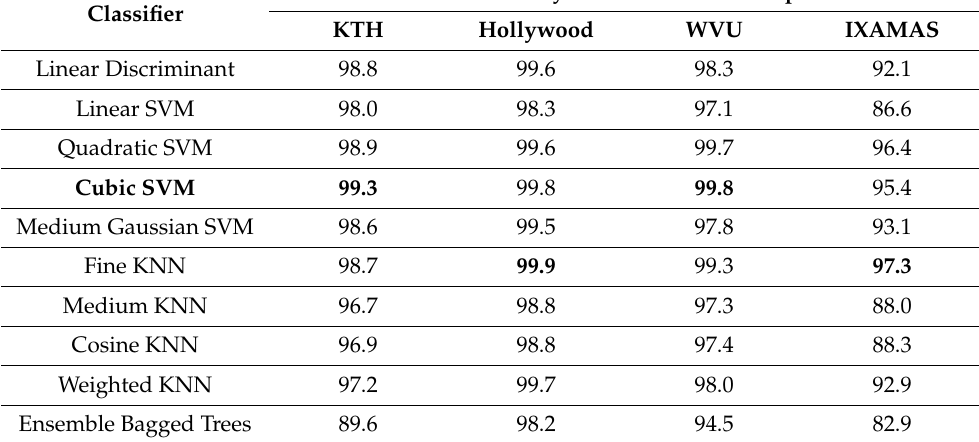
Table 1. Classification accuracy on specific DenseNet201 deep model. The bold represents the best obtained values.